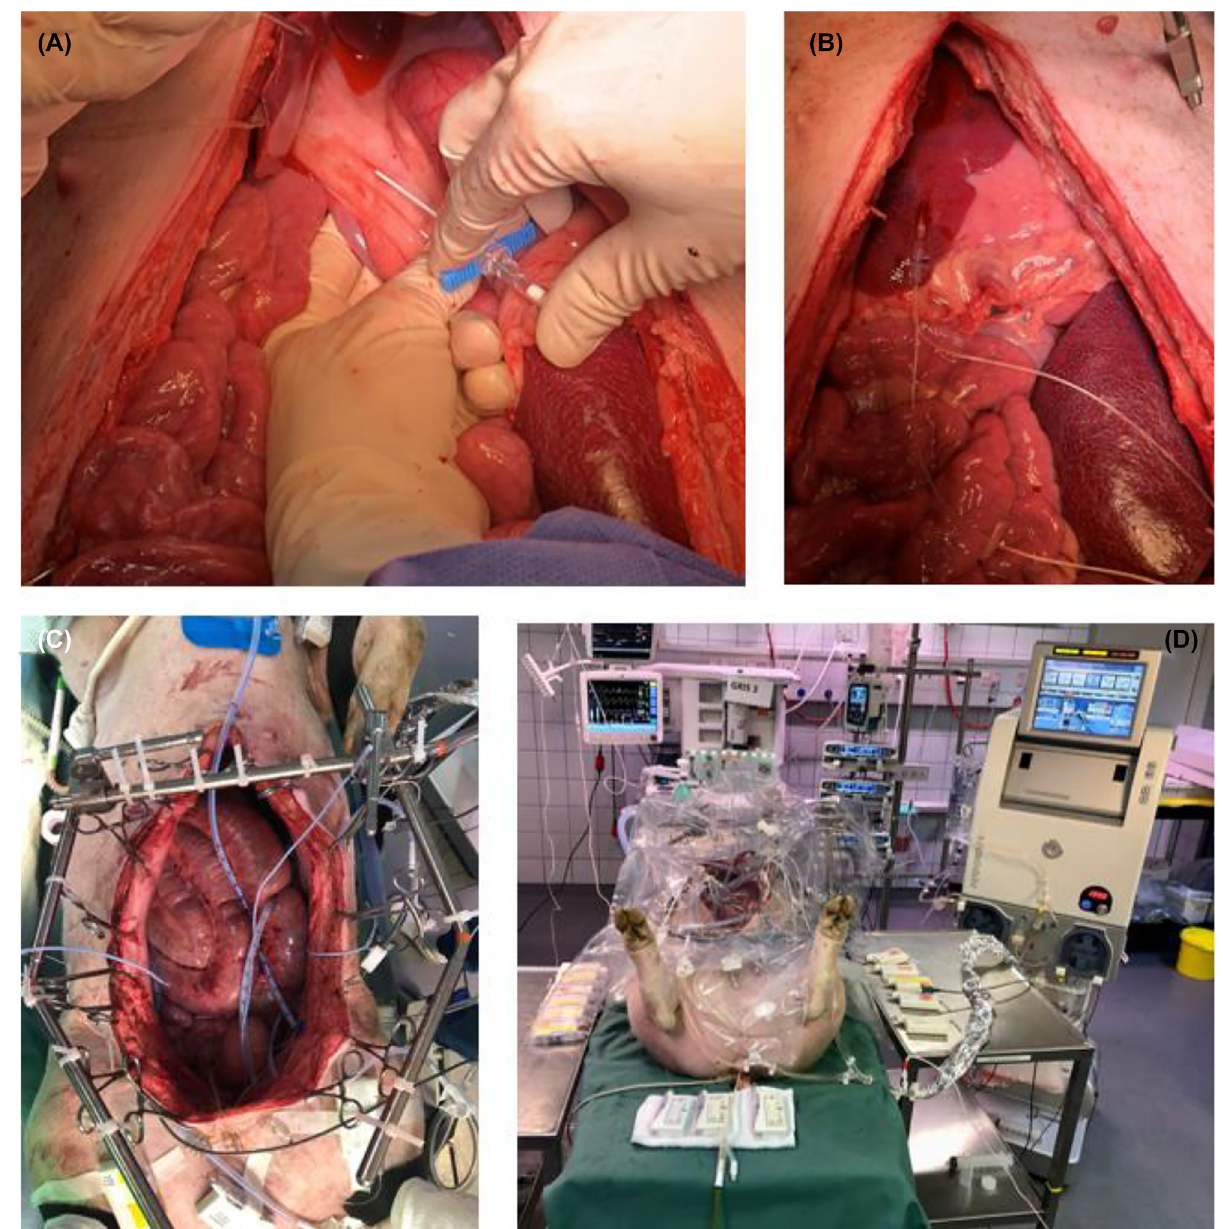
Figure 2: Illustrative example of placement of microdialysis catheter. (A) Illustrative exampleof placement of microdialysis catheter in hepatoduodenal ligament inserting an introducer. (B) Illustrative exampleof placement of a microdialysis catheter in the liver. The catheter is fastened to the liver tissue with a loose single suture to avoid displacement during sampling period. The same was done for all catheters. (C) Setup before HIPEC procedure seen from above. Placement of HIPEC tubes, HIPEC temperature probes and microdialysis catheters are shown. (D) Final setup placement of microdialysis pumps on tables, HIPEC performer system, and abdominal protection